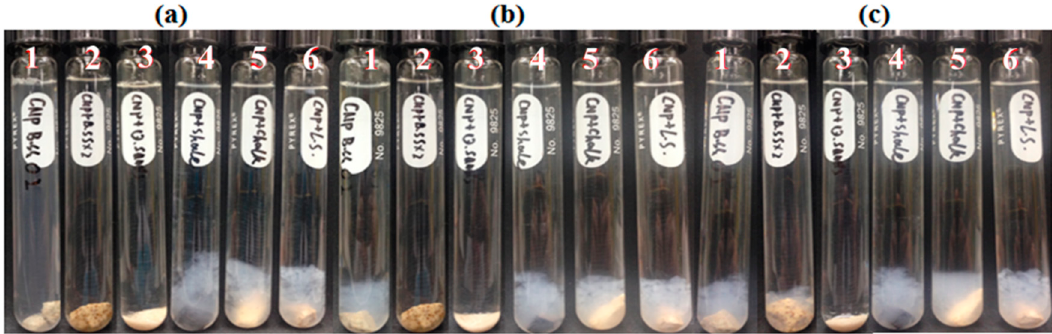
Figure 7. ANP suspensions with reservoir rocks: ( a ), Day 0; ( b ), Day 1; ( c ), Day 3. (1: BBS1; 2: BSS2; 3: quartz; 4: shale; 5: chalk; 6: limestone).